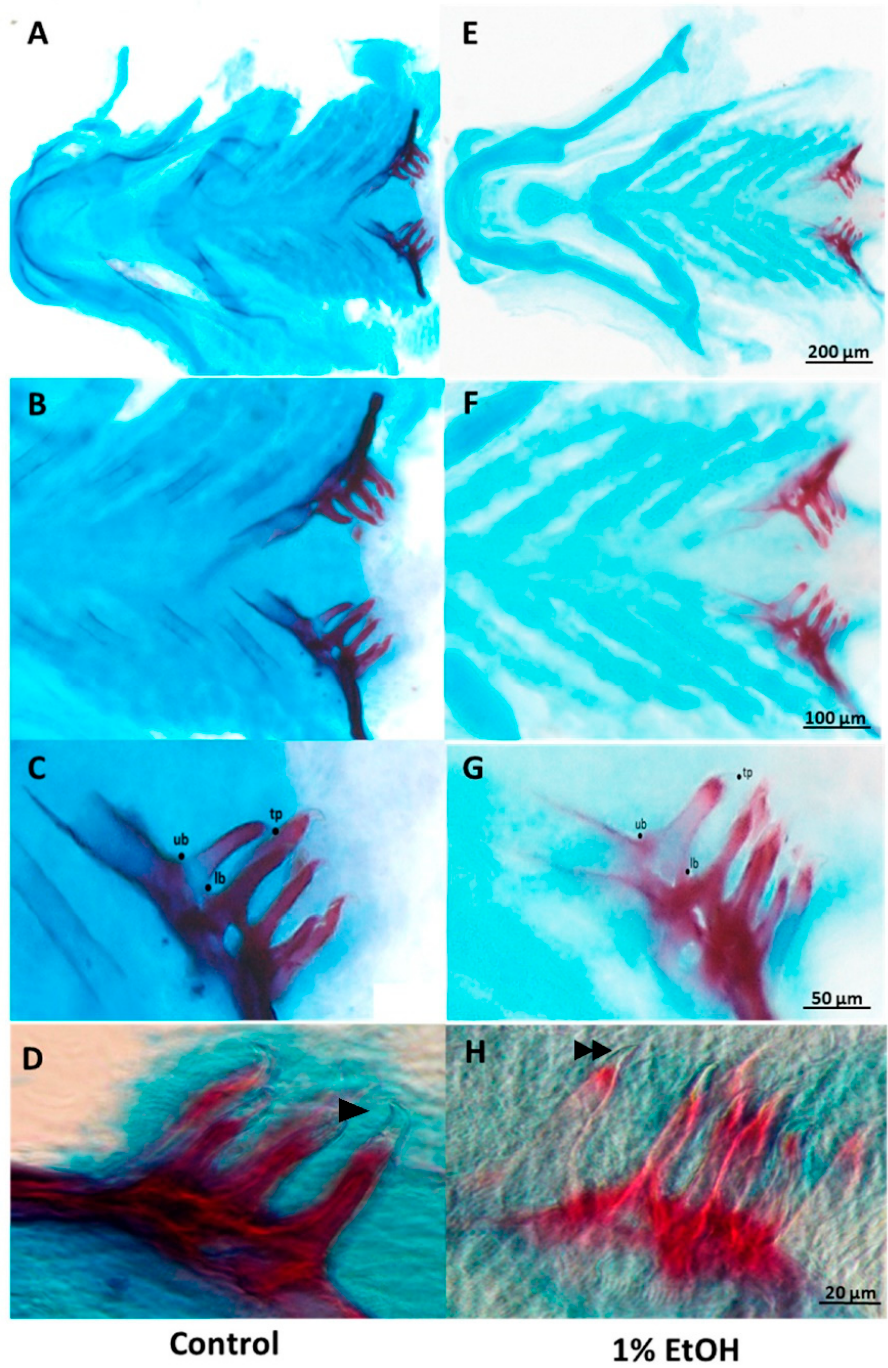
Figure 1. Acid-free double-stained tooth-bearing pharyngeal bones of zebrafish at 15 days post-fertilisation (dpf). ( A – D ) Control samples that show tooth-bearing lower pharyngeal bones with six teeth in each bone. These teeth were unicuspid and directly attached to the underlying bone. At this stage the teeth were fully mineralised. ( E – H ) Samples exposed to 1% alcohol at 10 h post-fertilisation showed small, malformed and hypo-mineralised teeth. ( D , H ) Enlarged view of the pharyngeal teeth with hooked cusp in control (arrowhead) and straight cusp in 1% alcohol-treated sample (double arrowhead) lb: lower base; tp: tip of the tooth; ub: upper base.